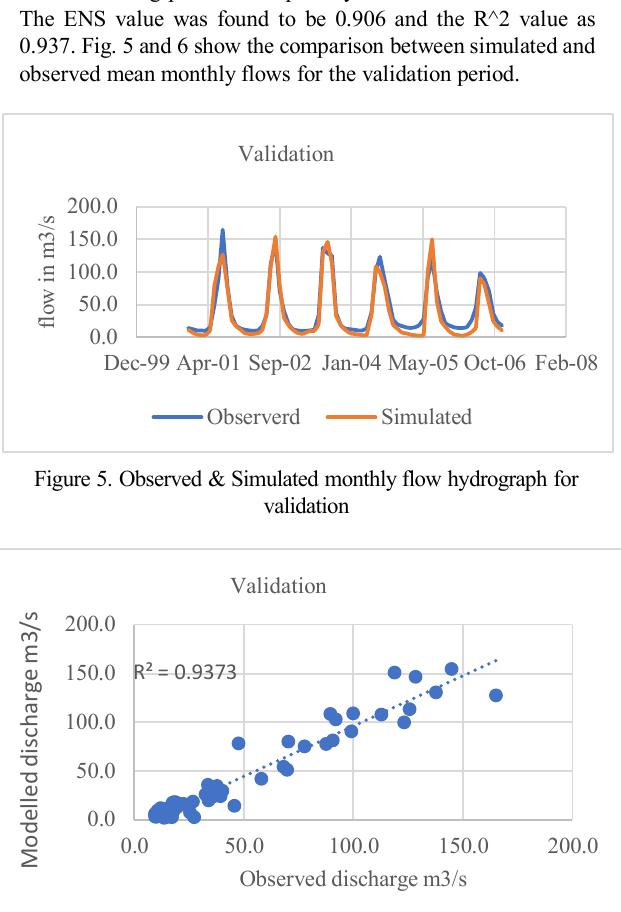
Table 6. Model calibration parameter